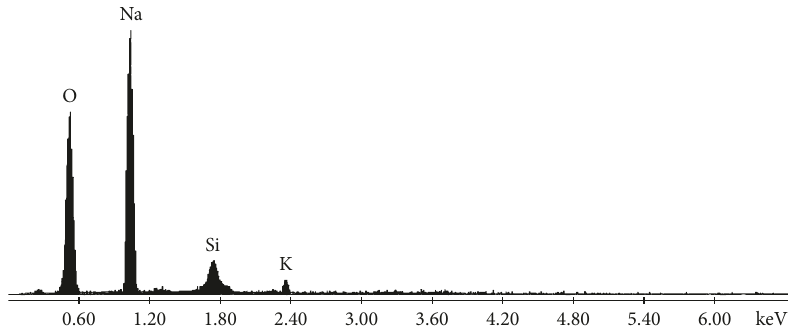
Figure 5: EDAX analysis at the position near A.